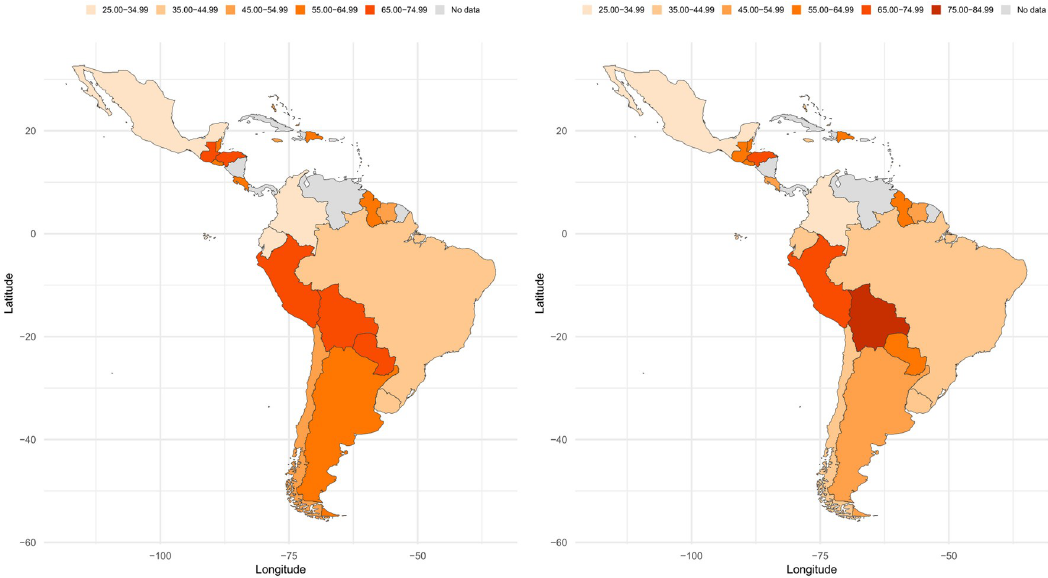
Fig 3. Prevalence of meeting the < 3 hours recreational SB cut-point among Latin American children and adolescents. Left: Boys; Right: Girls. These maps were rendered in RStudio 1.4.1103 using the rworldmap [25] and ggplot2 [26] R packages.